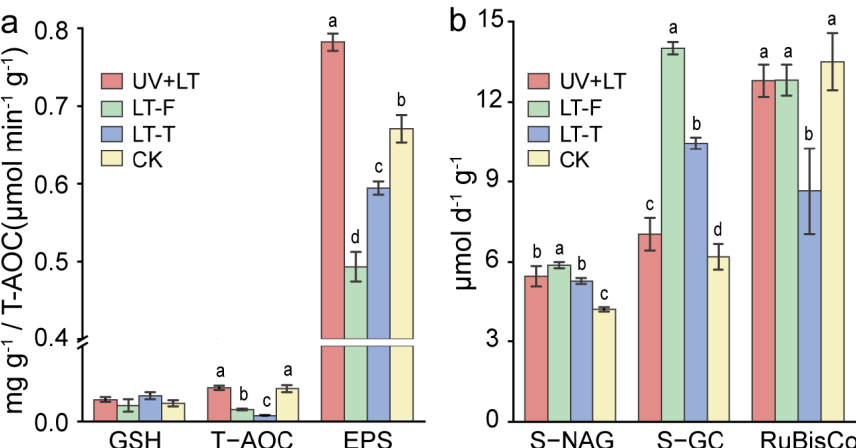
Figure 3. Stress resistance ability ( a ) and carbon metabolism enzymes activities ( b ) on cyanobacterial crusts. GSH, glutathione; T − AOC, total antioxidant capacity; EPS, exopolysaccharide; S − NAG, soil N-cetyl-D-lucosidase; S − GC, soil β -lucosidase; RuBisCo, ribulose-isphosphate carboxylase. UV + LT: stratospheric exposure; LT-F: low-temperature freezing; LT-T: low-temperature thawing; CK: natural control. Error bars show mean ± SD and different lowercase letters indicate significant difference (Tukey HSD; p < 0.05) between treatments and control ( n = 3).